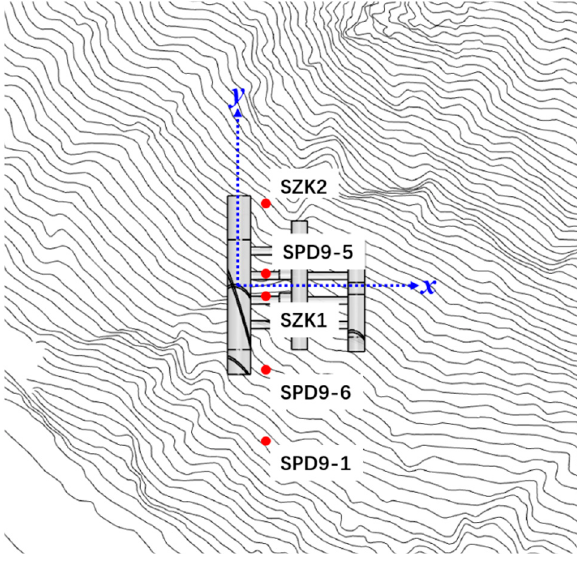
Figure 4. Distribution of in situ stress measured points. Table 3. Stress components from in situ stress measurements around the underground caverns.